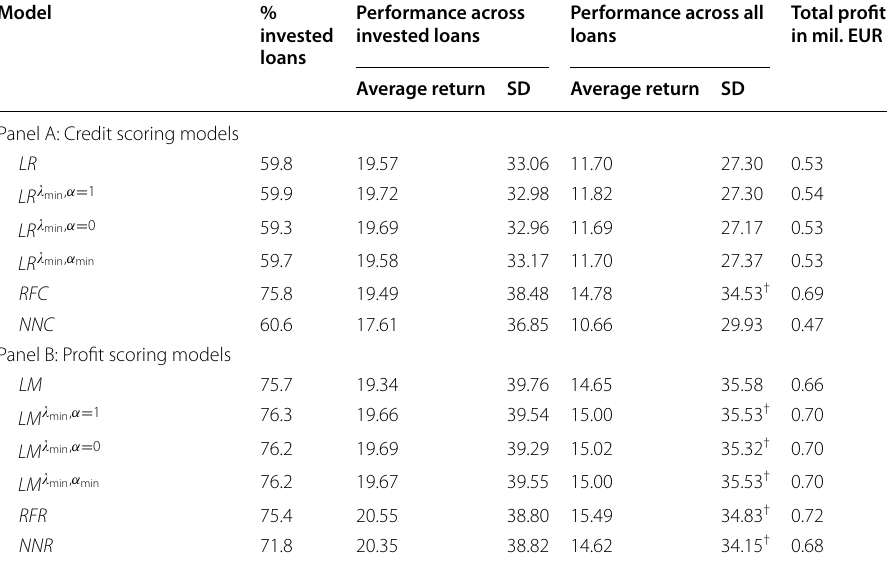
Performance across all loans